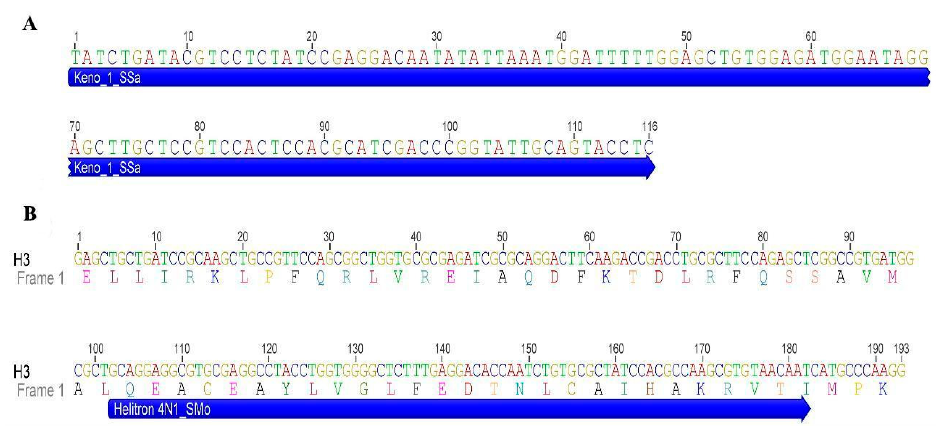
Figure 7. Repetitive DNA sequences isolated from the Trichechus genome: ( A ) partial sequence of U2 snRNA with similarity to non-LTR Keno_1_SSa retrotransposon (blue); and ( B ) partial H3 sequence of Trichechus showing a segment similar (102–182 bp) to the Helitron 4N1_SMo transposon (blue).